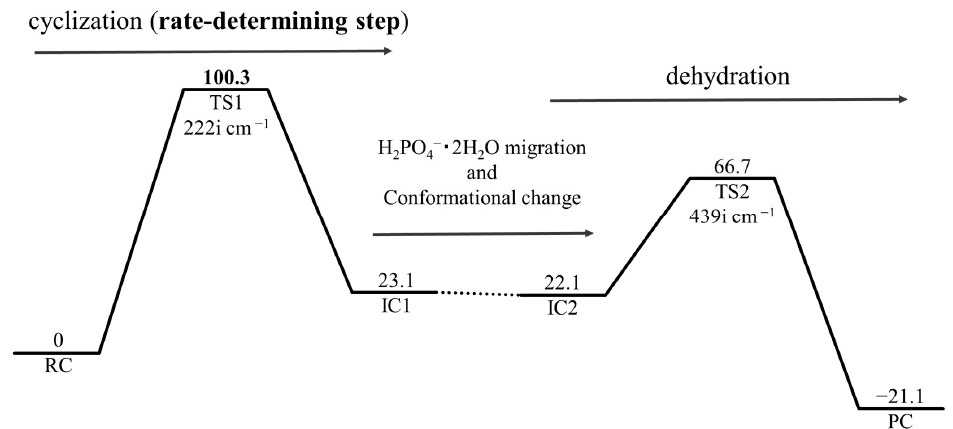
Figure 2. Energy profile for the two-step succinimide formation catalyzed by the H 2 PO 4 − ion. RC: reactant complex; TS: transition state; IC: intermediate complex; PC: product complex. The relative energies after the zero-point energy (ZPE), thermodynamic (25 °C), and hydration Gibbs energy corrections are shown in kJ mol − 1 with respect to the RC. Also shown are the imaginary frequencies of the two transition states.